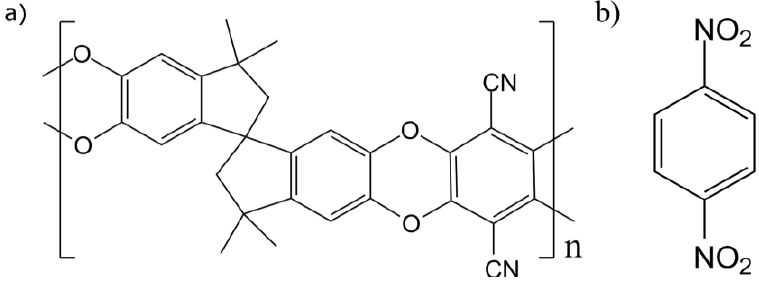
Figure 1. (a) Molecular structure of PIM-1; (b) Molecular structure of 1,4-dinitrobenzene (DNB).